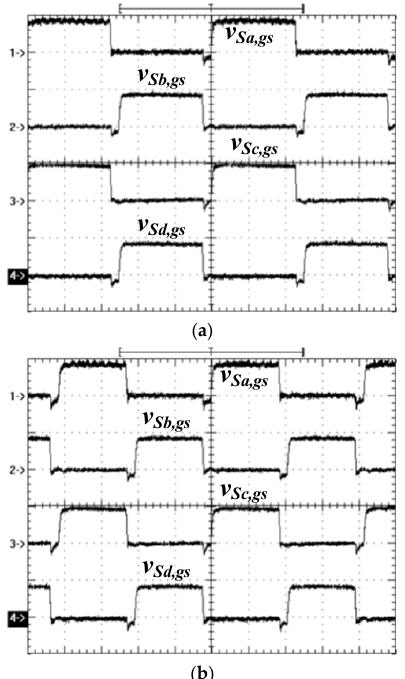
Figure 7. Measured waveforms v Sa,gs ~ v Ss,gs at 100% rated power under ( a ) 750 V input voltage ( v Sa,gs ~ v Sd,gs : 10 V/div; time: 2 μ s) and ( b ) 800 V input voltage ( v Sa,gs ~ v Sd,gs : 10 V/div; time: 2 μ s).